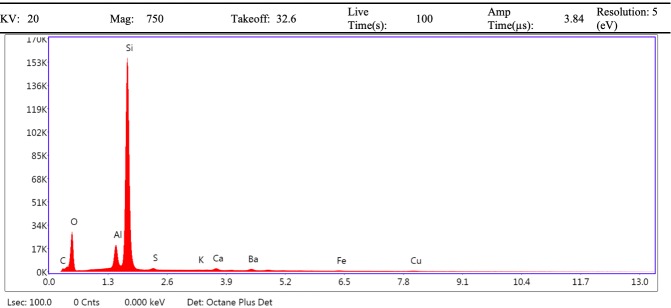
EDS spectrum of fibrous mass (spot 2) from demineralised Late Cretaceous.Centrosaurus bone area B.